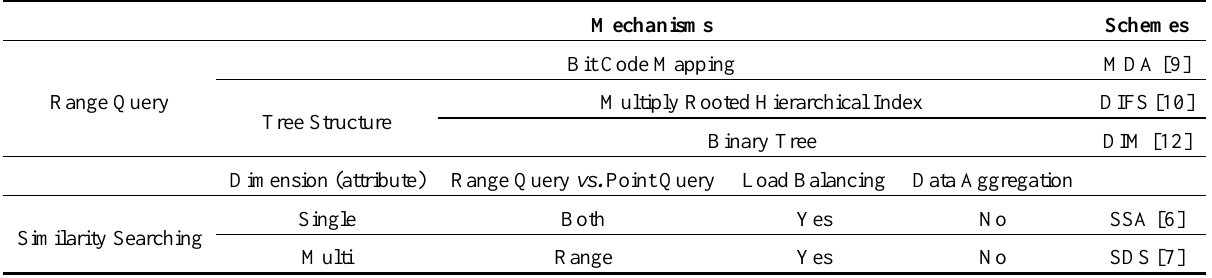
Table 1. Summary of relevant DCS